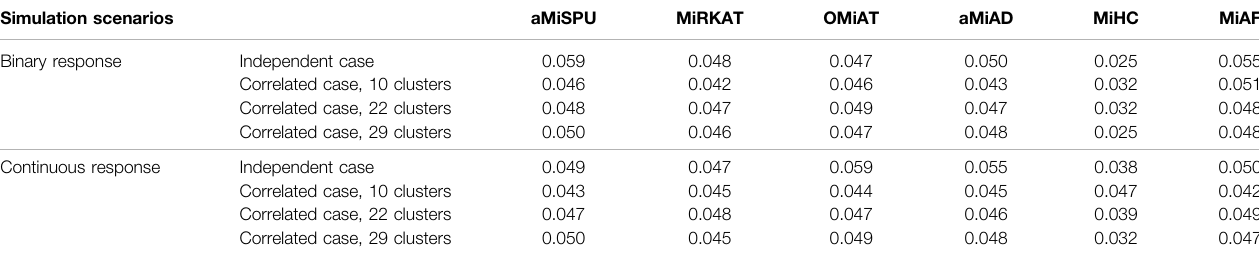
TABLE 2 | Type I error rates under independent case and mean type I error rates under correlated cases for both binary and continuous outcomes. Simulation